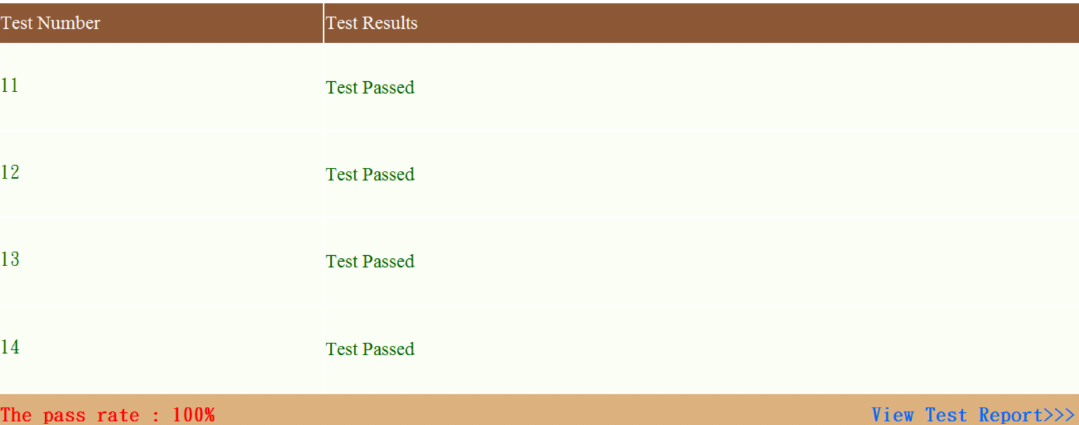
Figure 17. Example program (3), ( a ) Line 82 variable declares array size is 61*2, ( b ) Line 100 declares the arrays a and b and passes them as parameters on lines 106, 111, 117, 123.